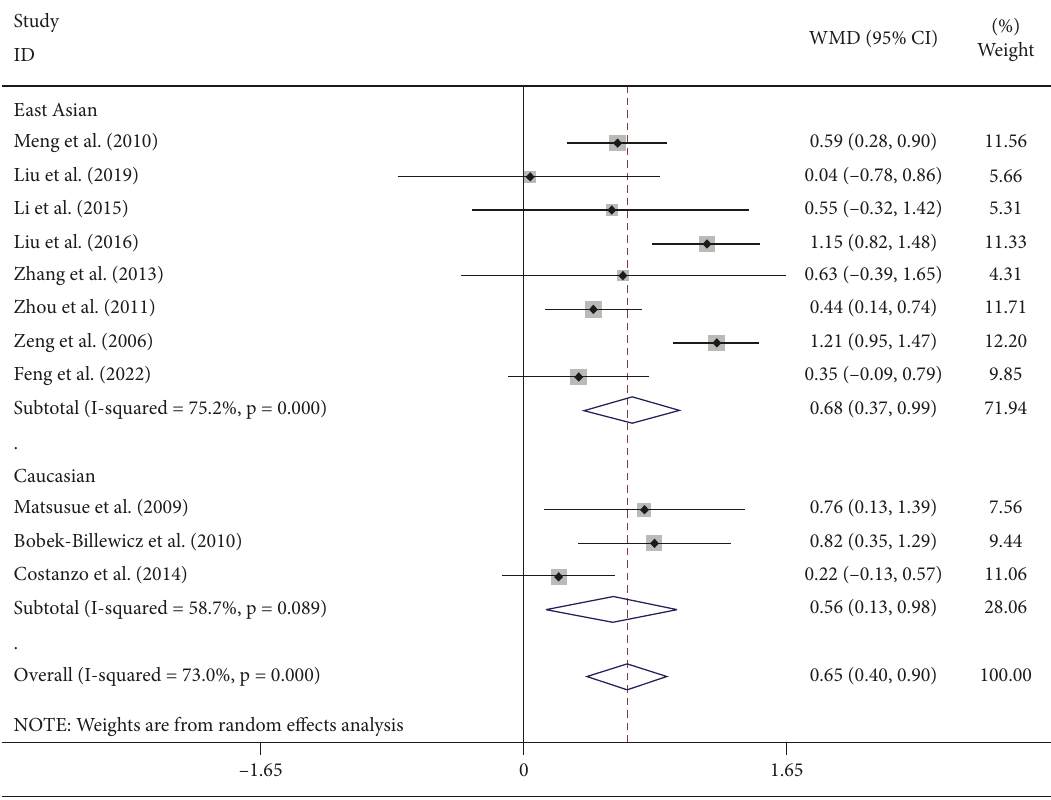
Figure 4: Forest plot of the Cho/Cr ratio of the radiation injury group and the recurrent glioma group detected by DWI combined with